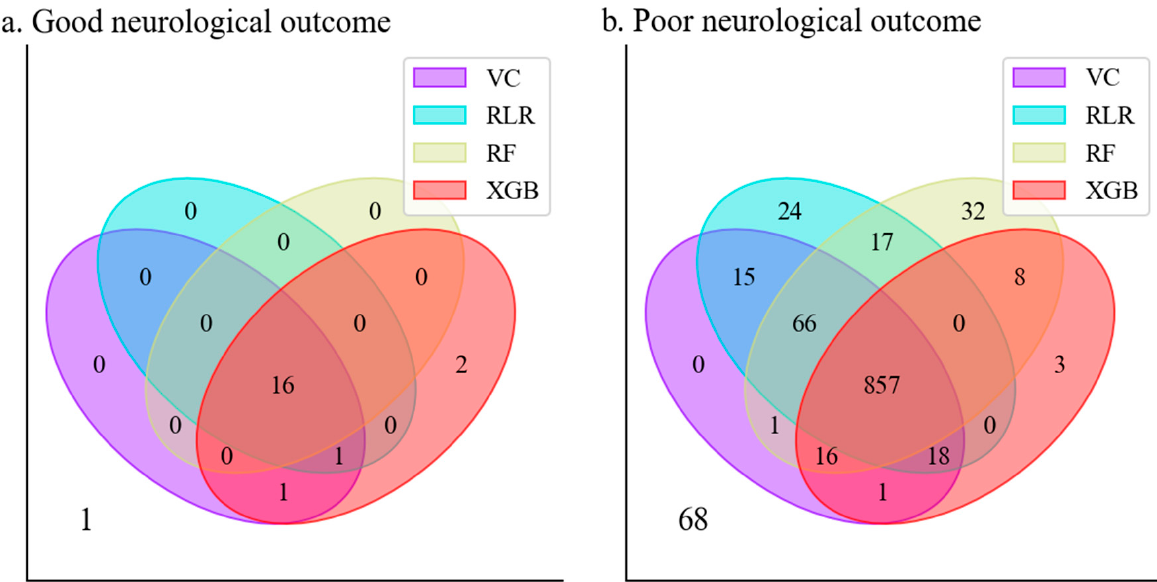
Figure 2. Venn diagrams of the predictions of neurological outcomes by model. ( a ) Comparison of predicted outcomes of the RLR, RF, XGB, and VC models for good neurological outcomes. ( b ) Comparison of predicted outcomes of the RLR, RF, XGB, and VC models for poor neurological outcomes.